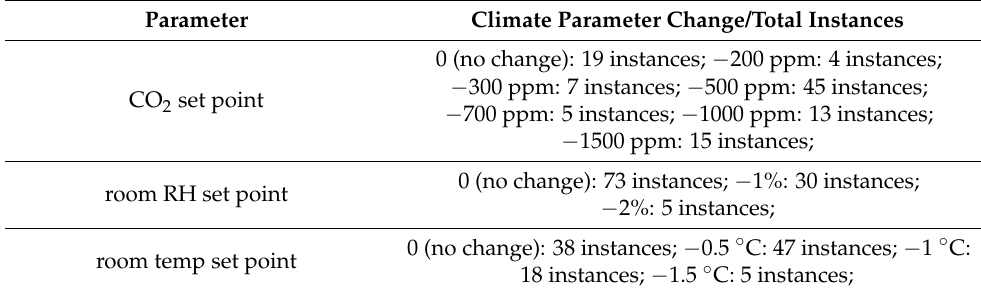
Table 4. Changes of climate parameters for the action to stimulate pinning.